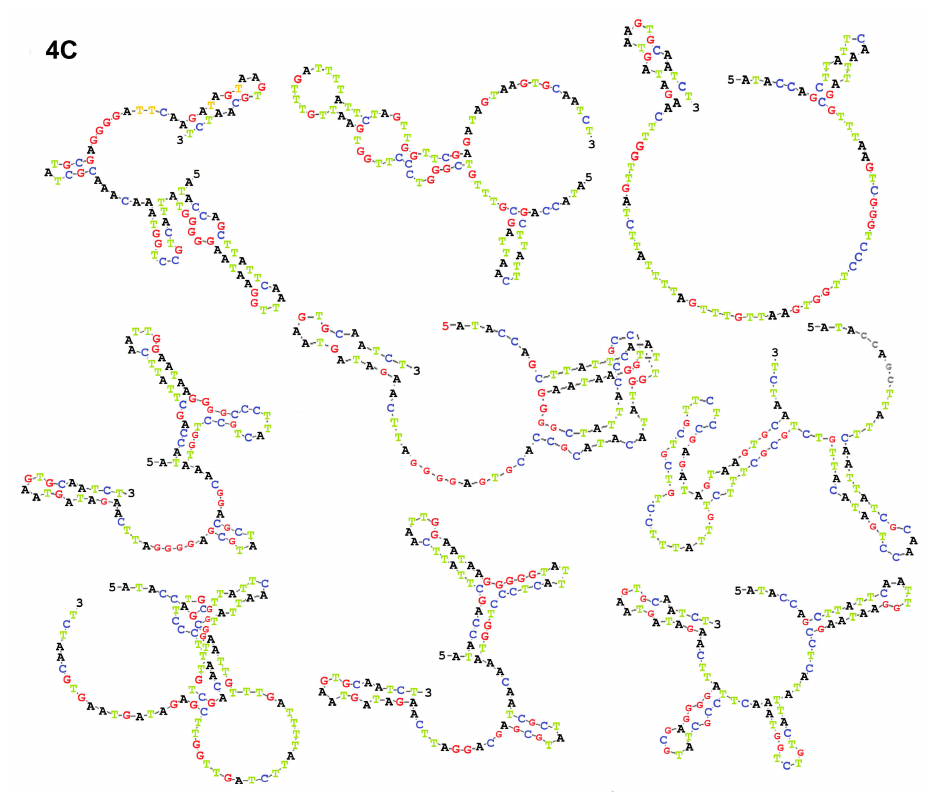
Figure 4. The secondary structure of AP-1 and the curve related to the calculation of K D . ( 4A ) the secondary structure of the AP-1 aptamer, as predicted by the DNAMAN ® software; ( 4B ) the correlation between aptamer concentration and MFI used to estimate K D ; ( 4C ) the secondary structure of the nine other aptamers are shown as the conformation predicted by the DNAMAN ®